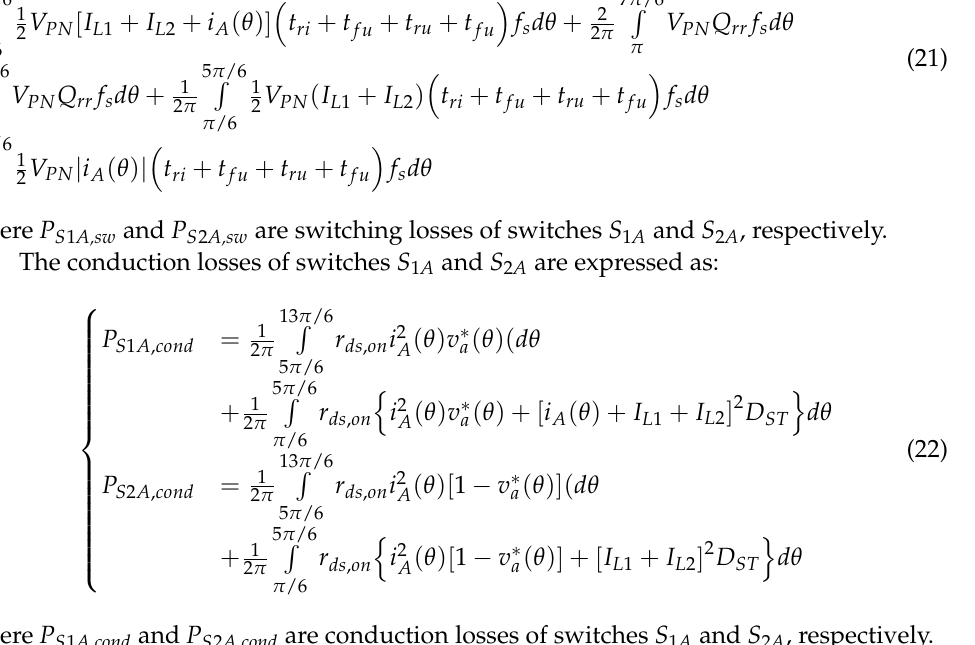
Table 2. Semiconductor and operating parameters.